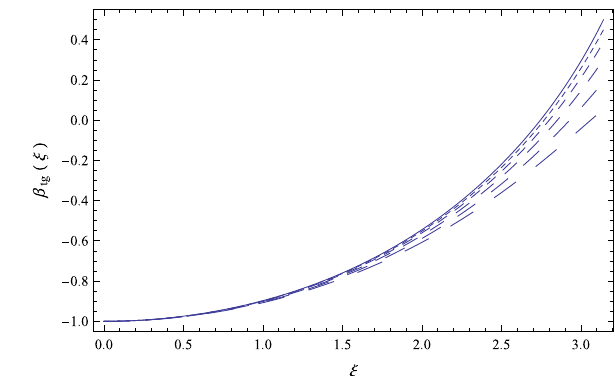
Fig. 5 Variation of the logarithmic slope of the tangential velocity β tg as a function of ξ = kr , for a rotating Bose–Einstein condensate dark matter halo for different values of (cid:14) 2 : (cid:14) 2 = 0 (solid curve), (cid:14) 2 = 0 . 01 (dotted curve), (cid:14) 2 = 0 . 0225 (short dashed curve), (cid:14) 2 = 0 . 04 (dashed curve), (cid:14) 2 = 0 . 0625 (long dashed curve), and (cid:14) 2 = 0 . 09 (ultra-long dashed curve),